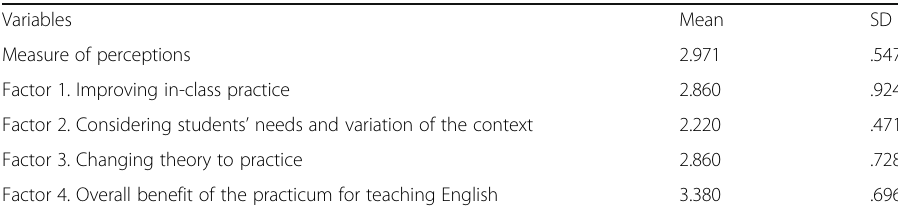
Table 3 Descriptive statistics of the variables